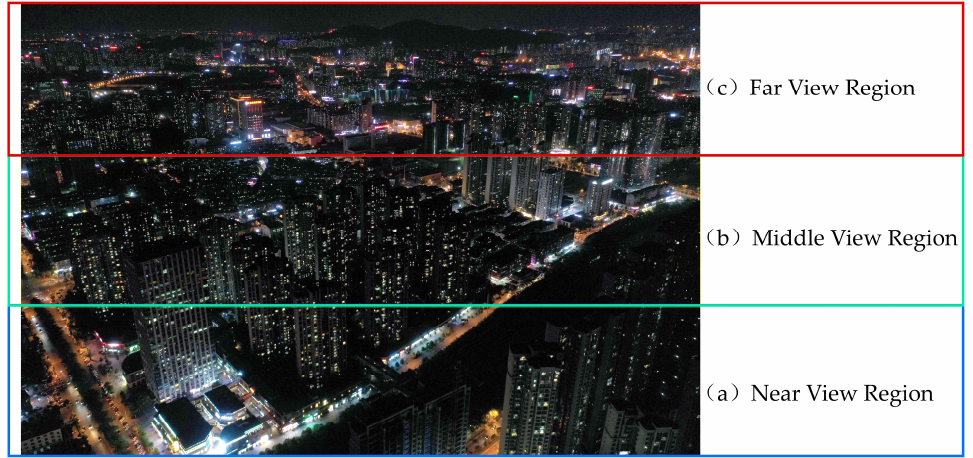
Figure 3. Equally divide the image into near, middle and far images along the direction of the field of view . of